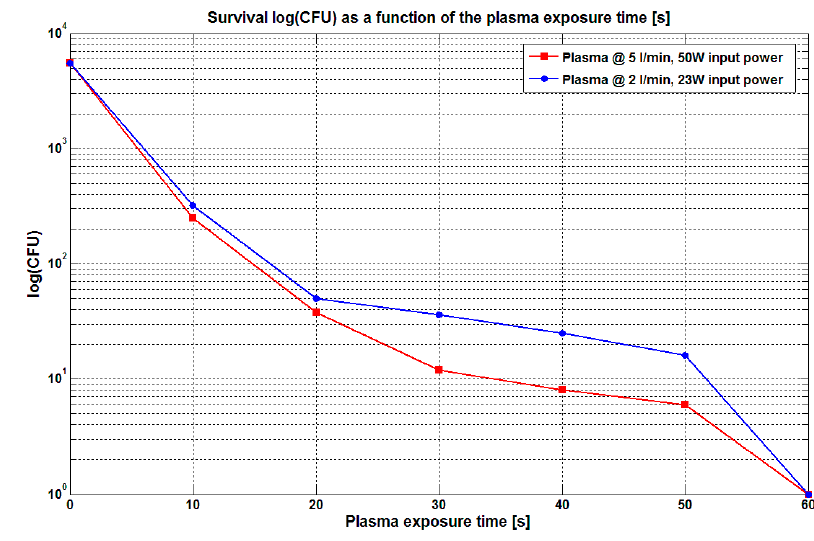
Figure 9. Inactivation of E. coli bacteria as a function of plasma treatment time.